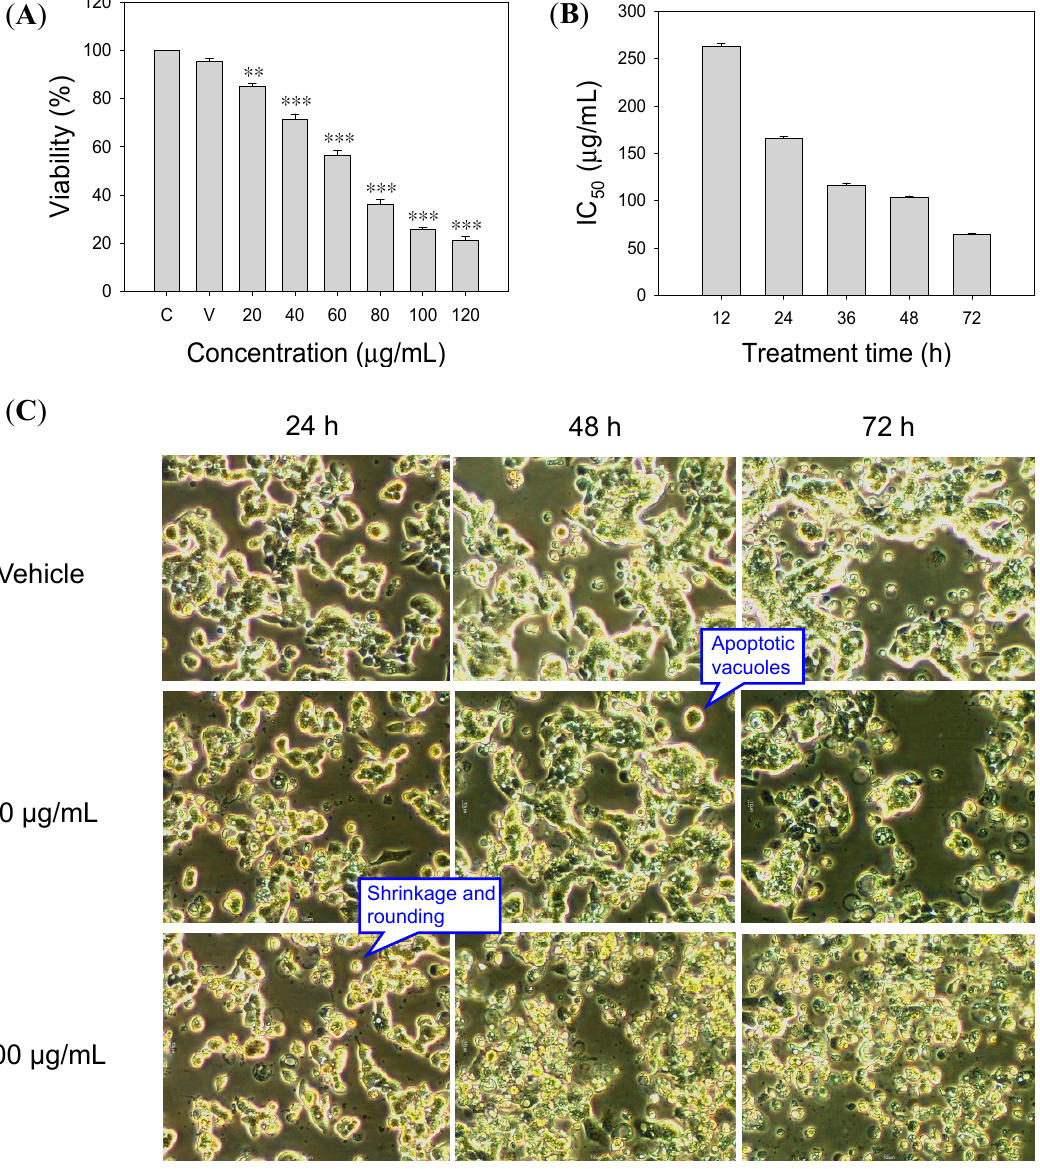
concentrations under different incubation durations. Experimental results indicate that SOE inhibited